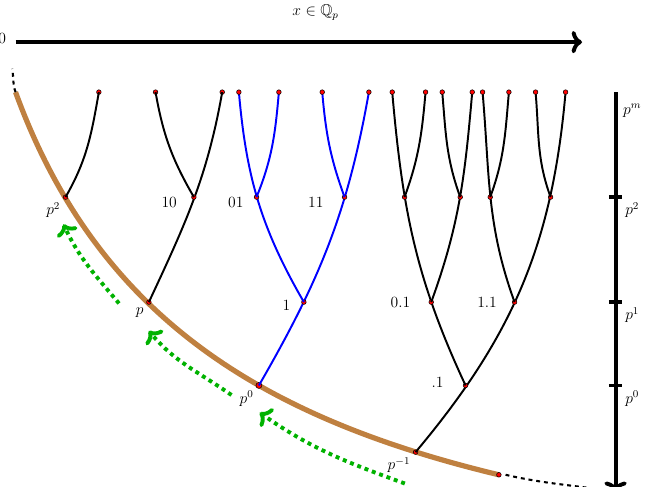
Figure 7. Bruhat-Tits tree for p = 2. The dilatation D on the tree slides the branches along the main